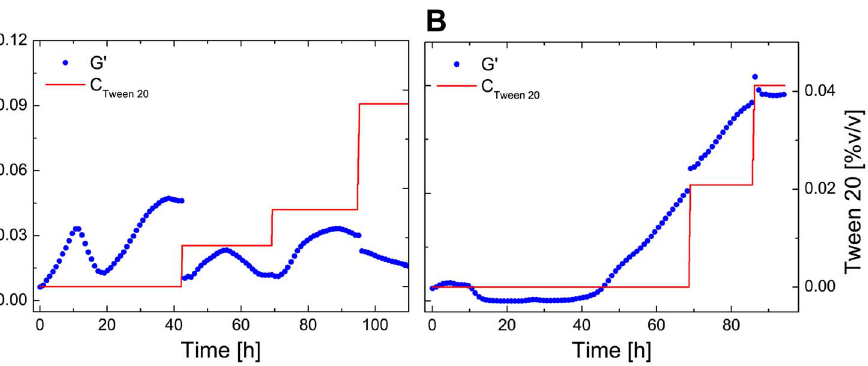
Figure 8. Effect of Tween 20 on biofilm elasticity after biofilm formation. The elasticity (G0) is plotted against the time and concentration of Tween 20 of P. fluorescens (A) and B. flsubtilis (B).